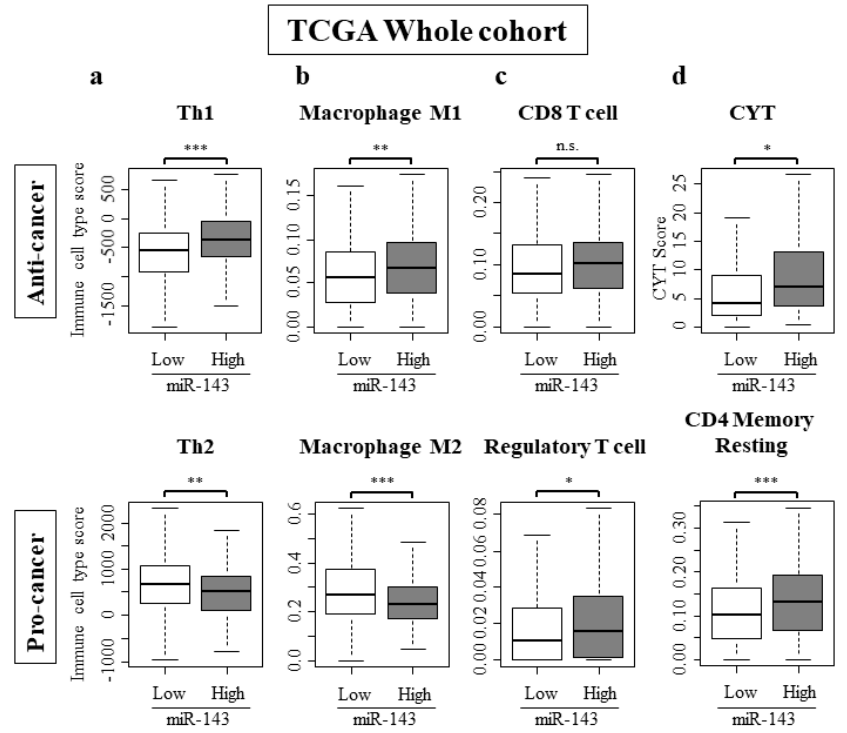
Figure 4. Immune cell composition within a tumor and CYT score. ( a ) Th1 was higher and pro-cancer immune cells Th2 were lower in miR-143 high expression group; ( b ) Anti-cancer immune cells, M1 was higher and pro-cancer immune cells M2 were lower in miR-143 high expression group. ( c ) Regulatory T cell was higher in miR-143 high expression group; ( d ) CYT was higher in miR-143 high expression group. * p < 0.05; ** p < 0.01; *** p < 0.001; n.s., not statistically significant. Th1, Helper T cell type 1; Th2, Helper T cell type 2; CYT, Cytolytic Activity.